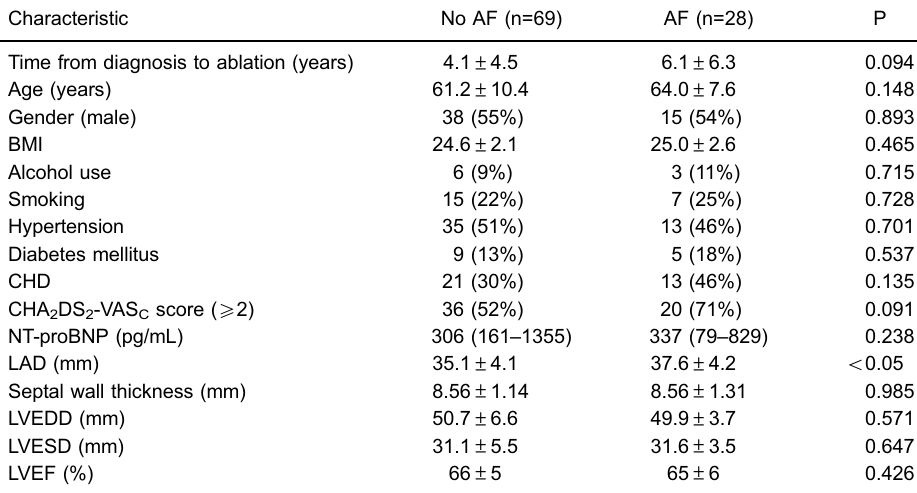
Table 1. Baseline patient